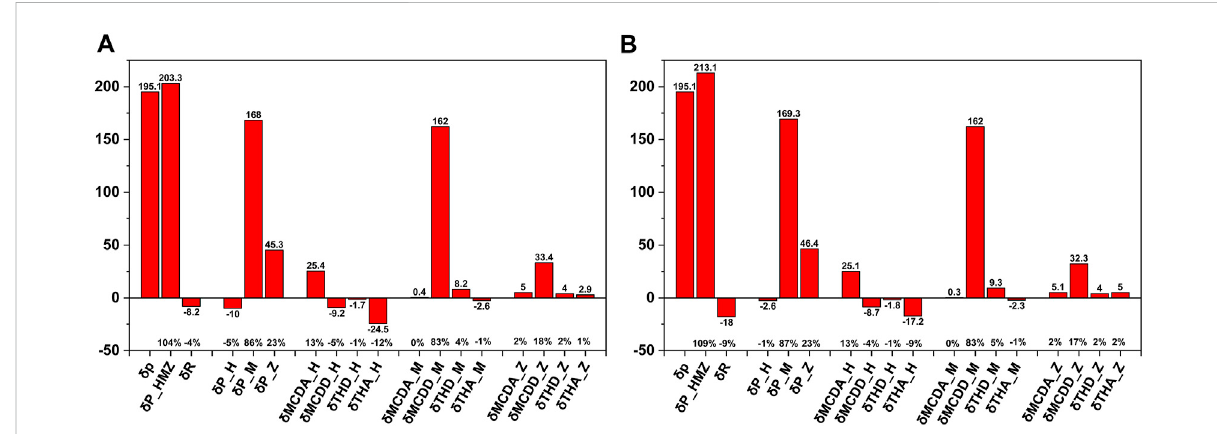
FIGURE 3 (A) Regionally averaged rainfall anomaly ( δ P) and the regionally averaged anomalous rainfall caused by changes in the moisture budget components over SC during the “ Dragon Boat Water ” season in 2022. δ P HMZ represents anomalous rainfall caused by the combined effects of horizontal, meridional, and zonal circulations (i.e., δ P H + δ P M + δ P Z). δ R represents anomalous rainfall caused by the residual term. The physical meanings of theother termsare thesame as those inFigure 2but for theregionally averaged values. The percentages onthe bottom represent the contributions of changes in the moisture budget components to δ P. (B) is the same as (A) but for the results where the upper limit of vertical integration ofEq.3changesto500 hPa.Unitsoftherainfallanomalyandanomalous rainfallcausedbychangesinthemoisturebudget components are